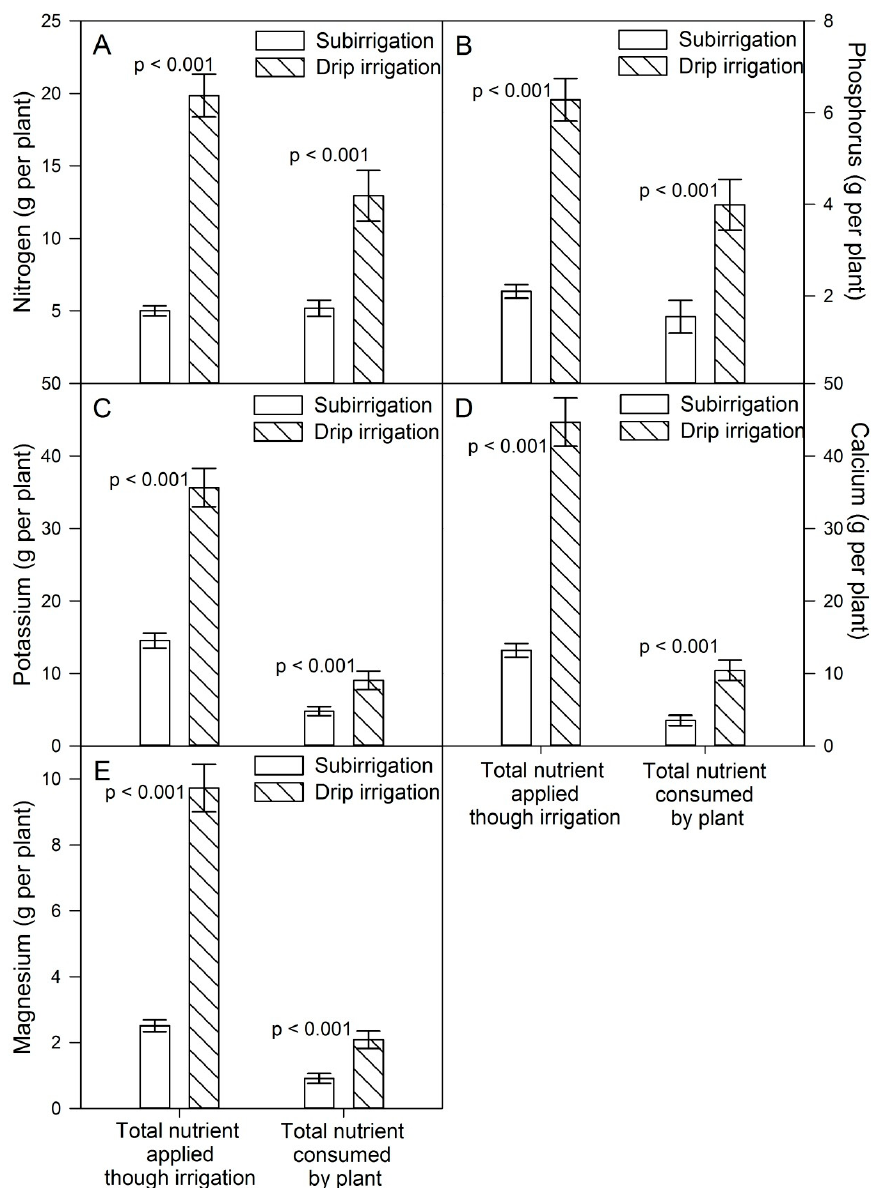
Figure 4. Nitrogen ( A ), phoshorus ( B ), potassium ( C ), calcium ( D ) and magnesium ( E ) use